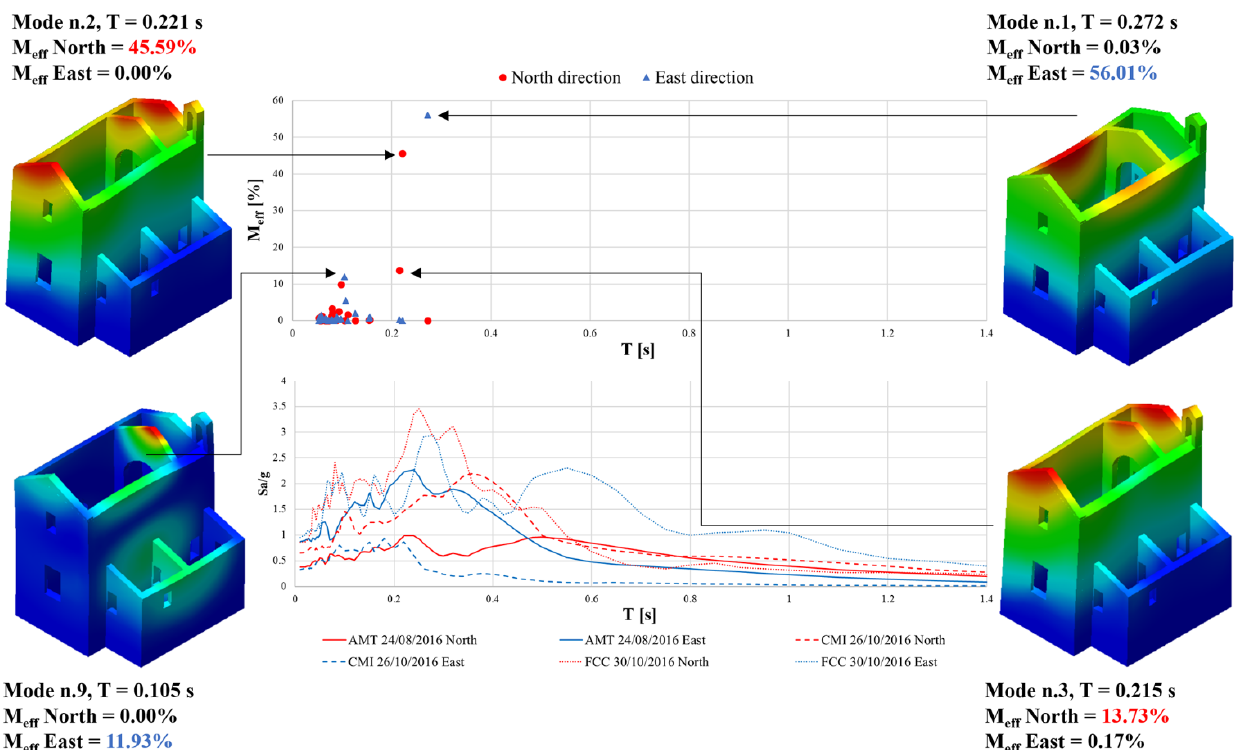
Figure 7. Distribution of modal shapes in the longitudinal and transversal directions and comparison with the pseudo- acceleration response spectra of the three main shocks of Central Italy seismic sequence of 2016 for Sant’Anna Church in Camerino (Macerata, Central Italy).